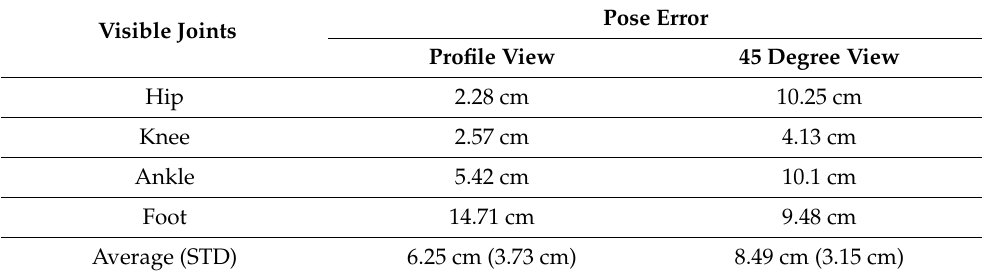
Table 5. MeTRAbs 3D Body Pose error results. STD: standard deviation. Distance: 3.2